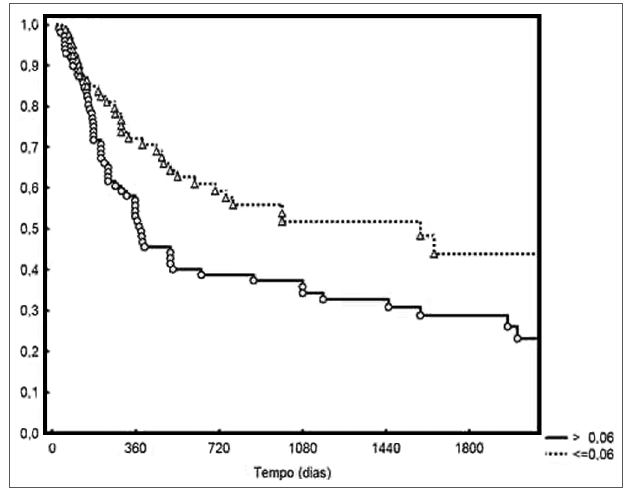
Figura 2. Sobrevida livre de doença para os grupos com densidade linfonodal abaixo ou acima da